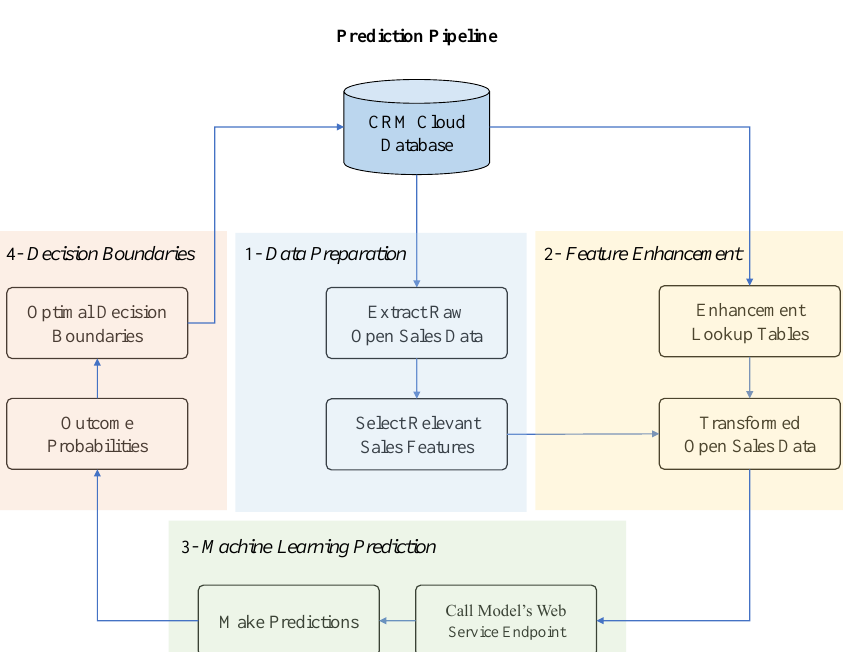
Figure 6. Prediction Pipeline: new sales opportunities data are transformed and enhanced, probability of winning is inferred using the trained ML model, and finally decision boundaries are optimized based on historical sales